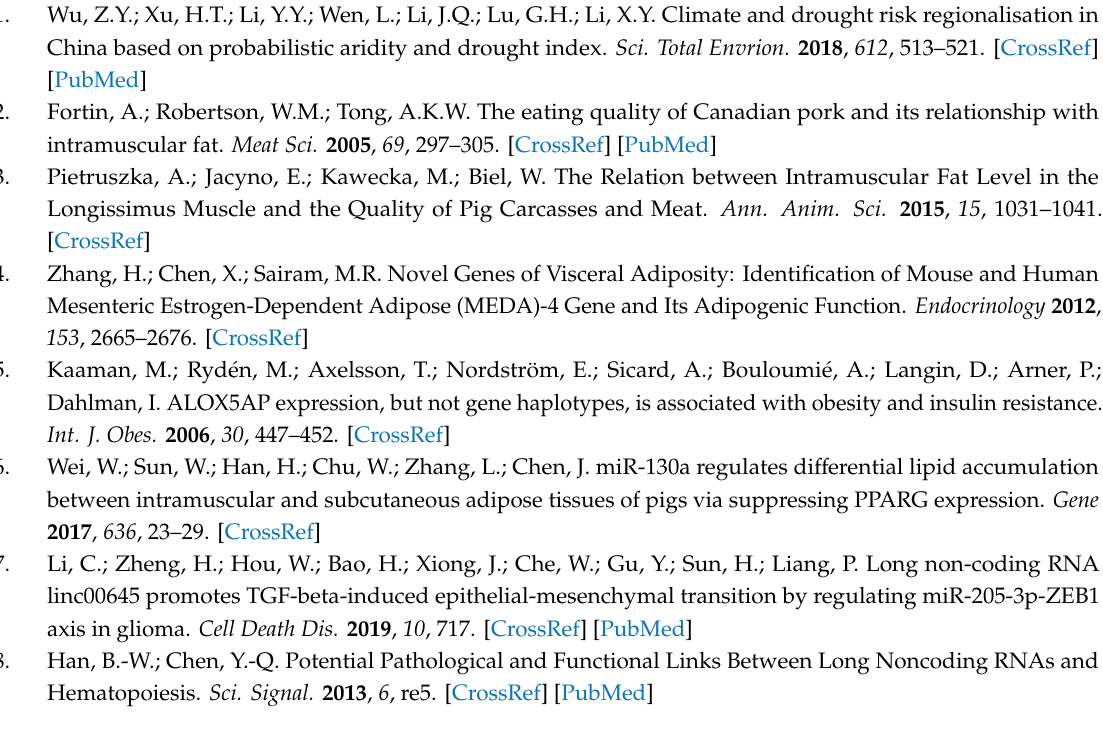
s1. Table S1: QTL mapping analysis on DE lincRNAs, Table S2: Gene ontology and pathway analysis of PTGs of DE lincRNAs, Table S3: Gene ontology and pathway analysis of DEPTGs of DE lincRNAs, Table S4:The expression regulation relationship between DEL genes and their DEPTGs, Table S5: Sequence information of lincRNAs used in RT-qPCR, Table S6: The information of seven pairs of RT-qPCR primers. Author Contributions: C.L. conceived and designed the experiments and explained the data; Q.L. analyzed main content of the data with the help of Z.H.; M.L. performed the experiment with the help of W.Z.; Q.L. wrote the paper with the help of C.L. All authors have read and agreed to the published version of the manuscript. Funding: The work was supported by the National Natural Science Foundation of China (NSFC, 31872322), the Fundamental Research Funds for the Central Universities (2662017PY030), the National R&D Project of Transgenic Animals of Ministry of Science and Technology of China (2016ZX08006-003), and the National high technology research and development plan (863,